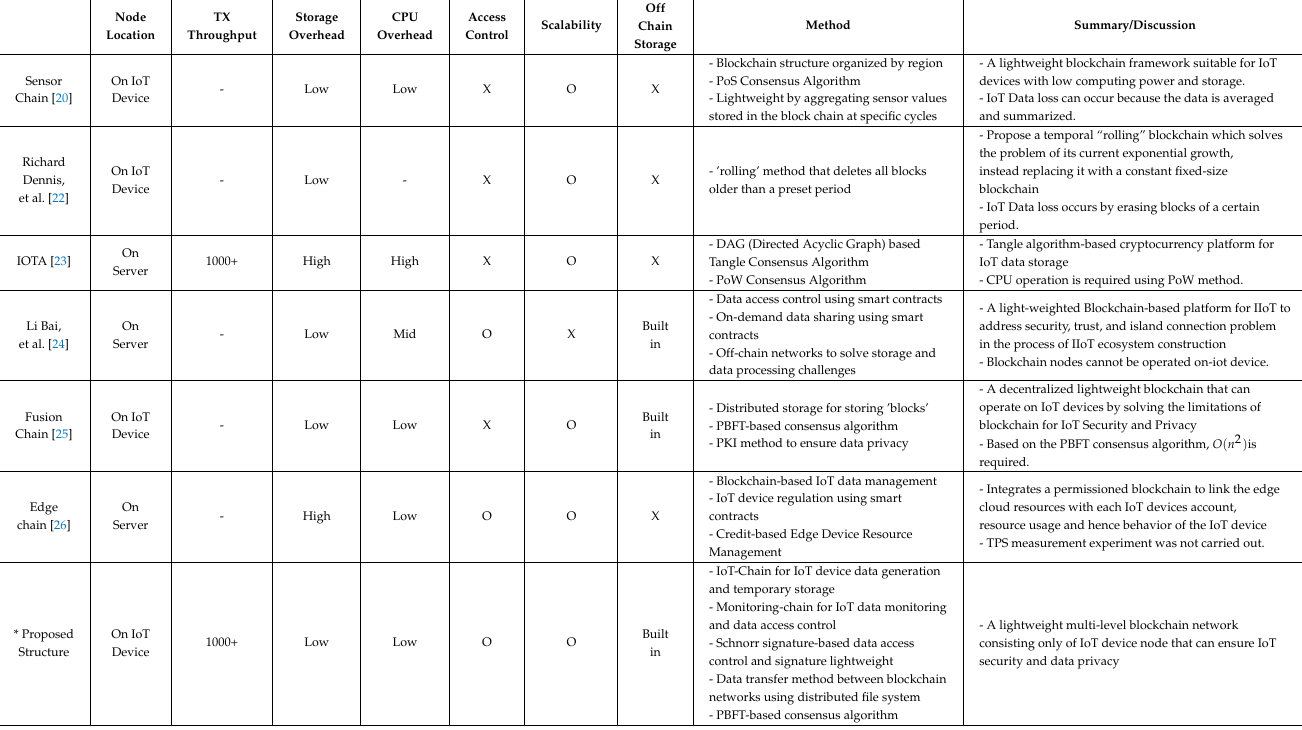
Table 1. Comparison of the existing Lightweight